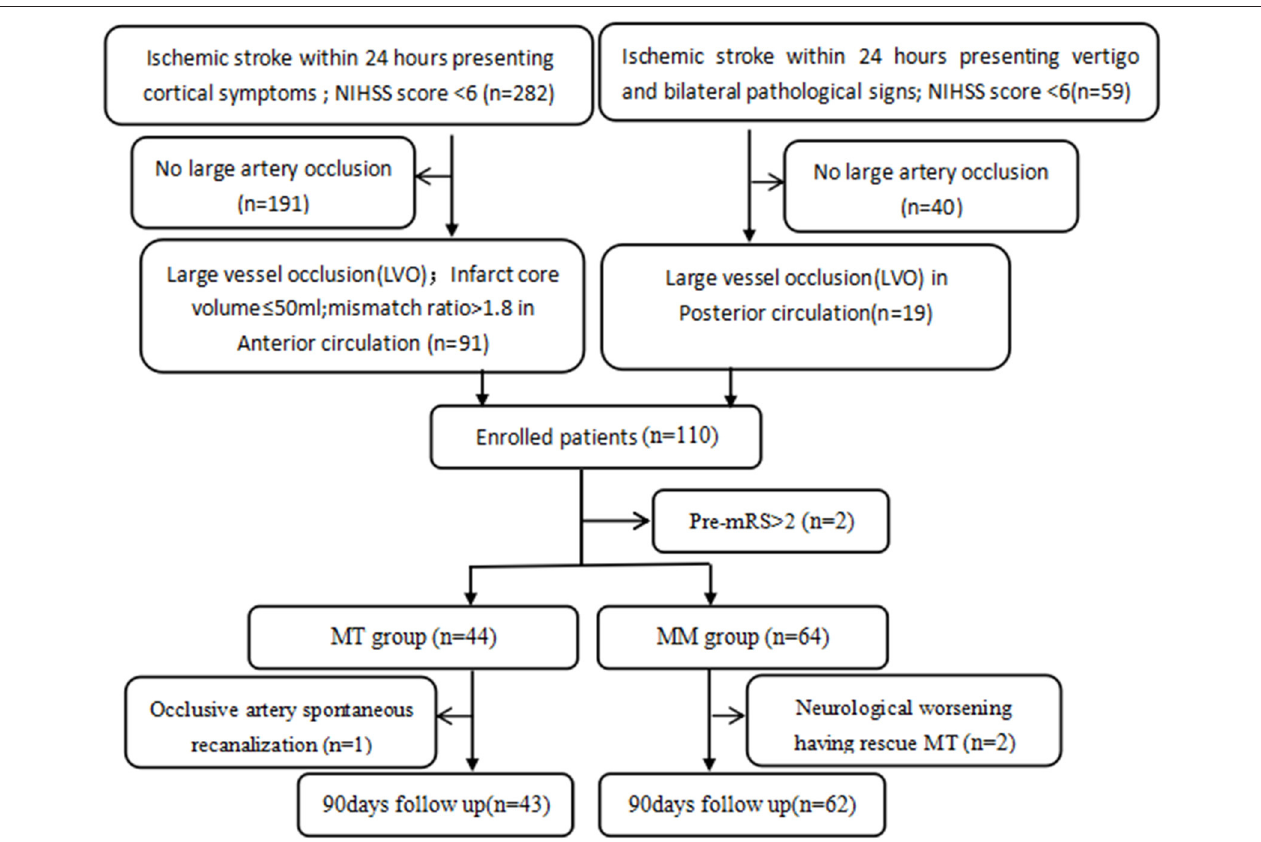
FIGURE 1 | The study flowchart. NIHSS, National Institutes of Health Stroke Scale; mRS, modified Rankin Scale; MT, mechanical thrombectomy; MM, medical management; LVO including middle cerebral artery M1, proximal M2 segment, intracranial internal carotid artery, basilar artery, and posterior cerebral artery P1